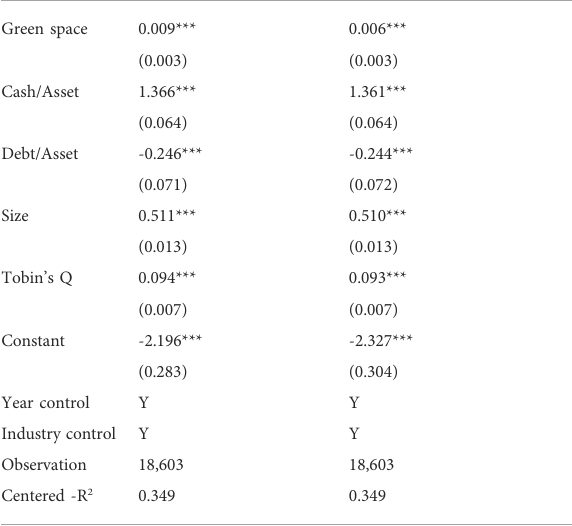
TABLE 3 Alternative measurement of